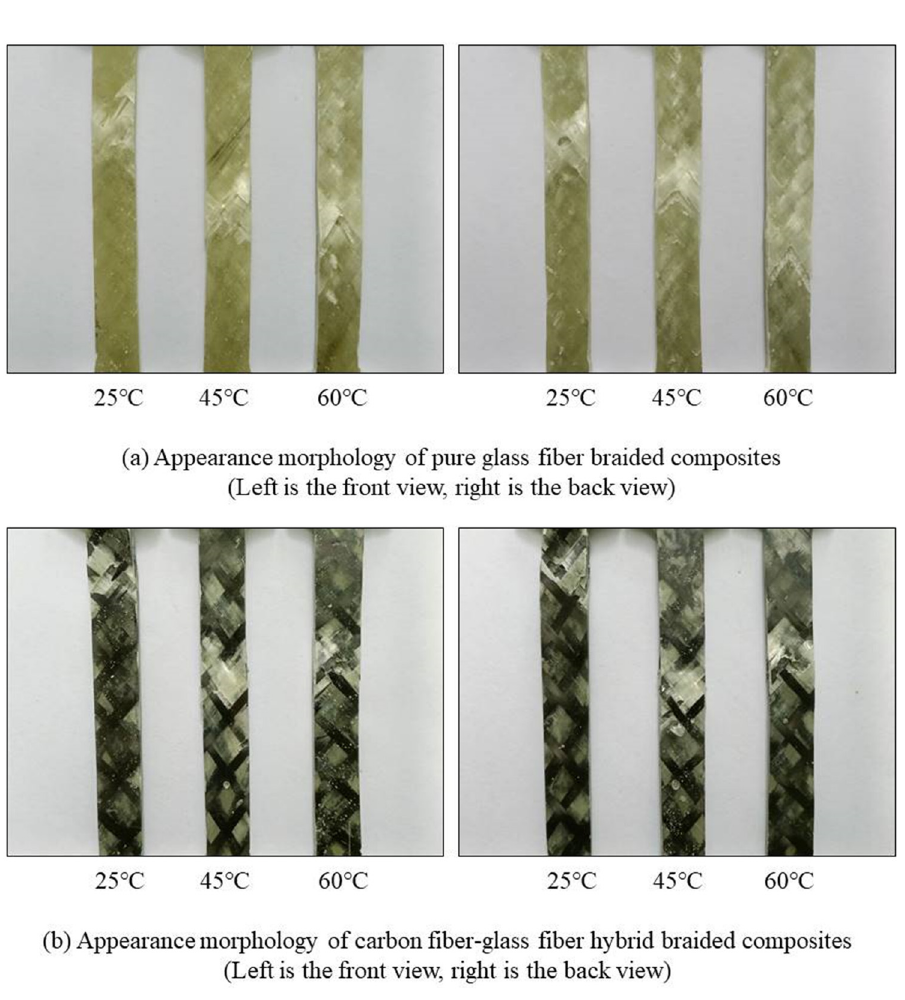
Figure 10: Appearance morphology of 2D braided composites: ( a ) pure glass fi ber braided composites and ( b ) carbon fi ber - glass fi ber hybrid braided